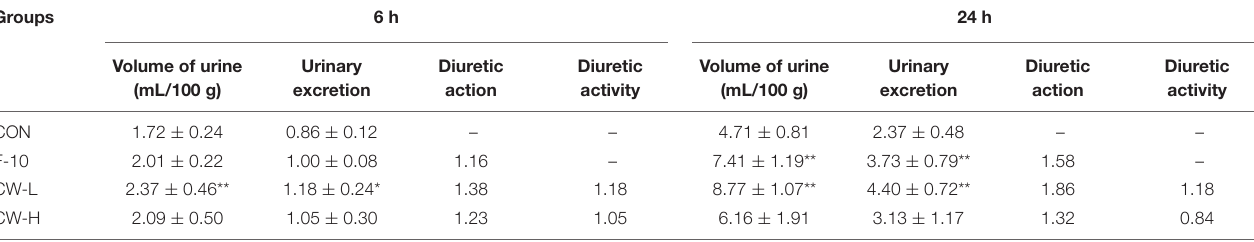
TABLE 3 | The effect of acute treatment with coconut water on urinary excretion volume at 6 and 24 h in rats. Groups